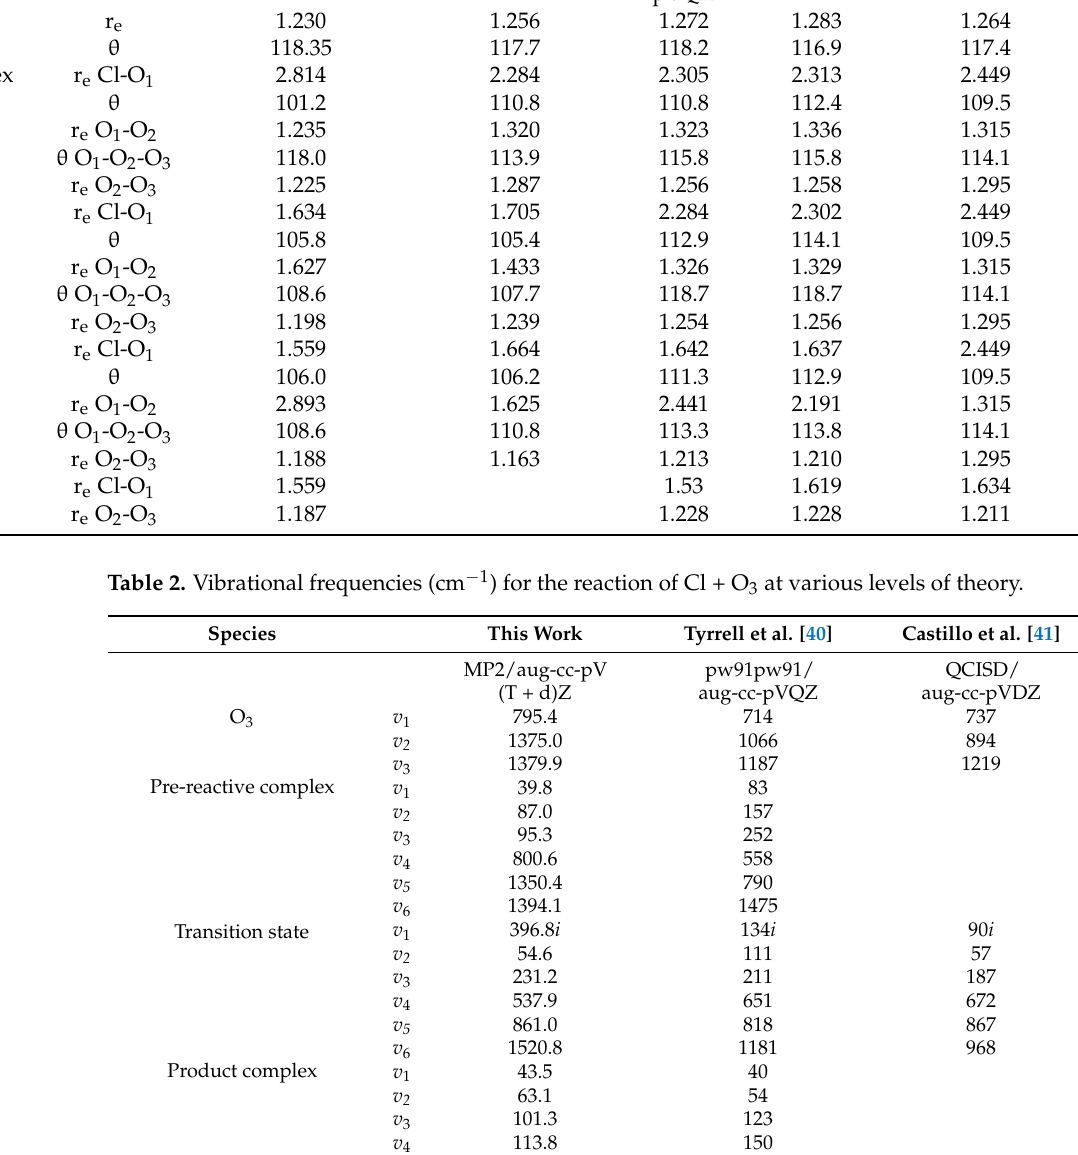
Table 1. The obtained bond lengths (r e in Å) and bond angles ( θ in deg) for the reaction of Cl + O 3 at various levels of theory. Species This Work Hwang et al. [39] Tyrrell et al. [40]